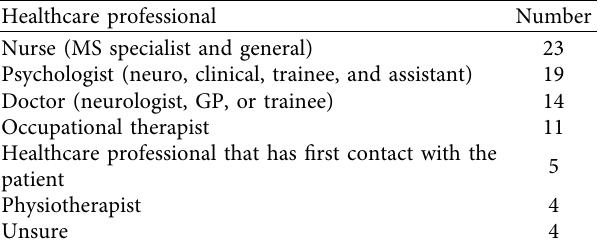
Table 6: HCPs reported in a survey who assess mood in people with